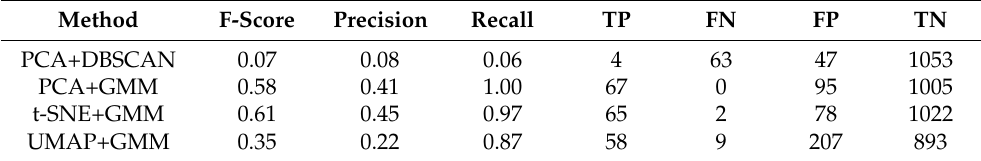
Table 5. Experiment results for Dataset 2 where ANCs are NOT considered as True